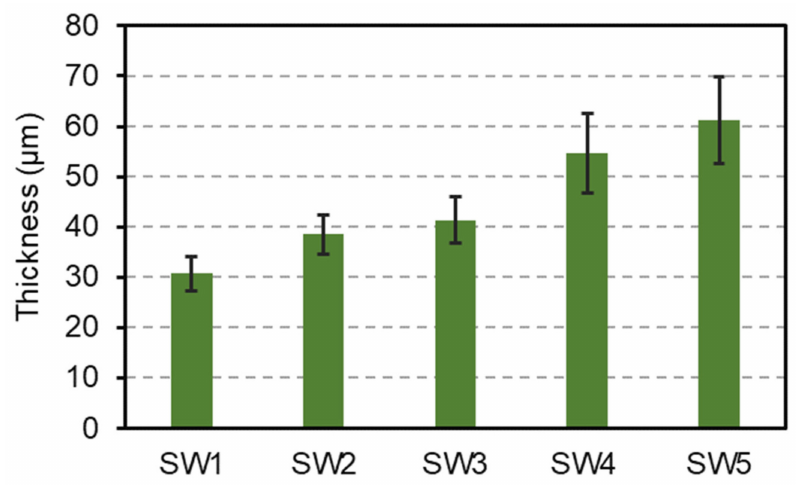
Figure 1. Thickness of the cured coating layers. The adhesion strength values of the coatings at the surface of beech wood are shown in Figure 2.